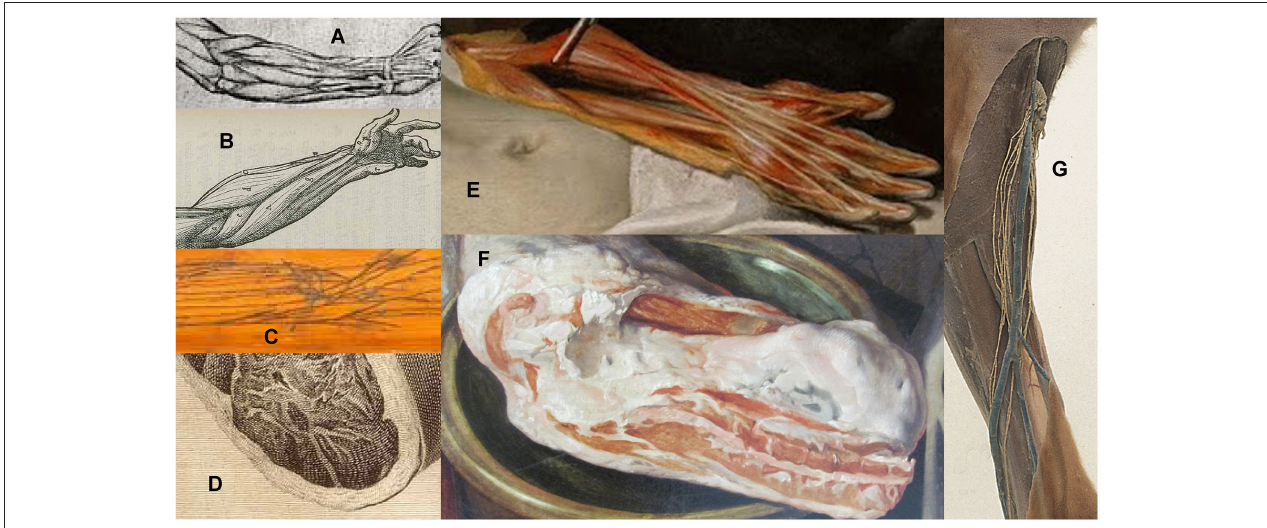
FIGURE 1 | “White” adipose tissue: omitted from human forearm by (A) Leonardo da Vinci, c. 1510, (B) Vesalius 1543, (C) anatomy table; depicted in details from (D) woman’s thigh in Plate VI, van Riemsdyk ( Hunter, 1774), (E) man’s arm in The Anatomy Lesson of Dr. Nicolaes Tulp , Rembrandt 1632, (F) pork in The Four Elements: Fire , Beuckelaer 1570. (G) prosection showing dog popliteal lymphatics and blood vessels (Royal College of Surgeons,